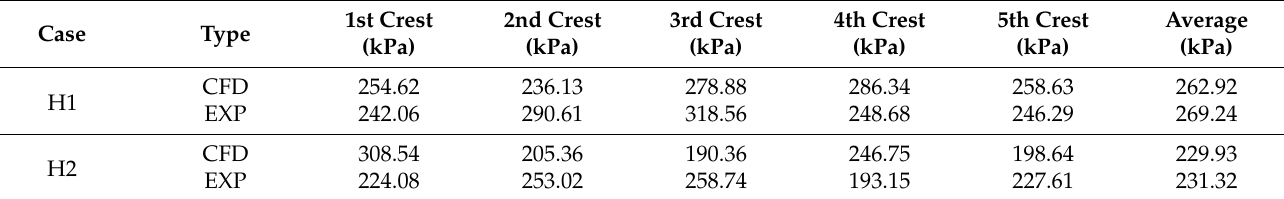
Figure 13. Comparison of slamming pressure at K1 between experimental data and numerical results. Test conditions are: ( a ) H = 15 m, T = 9 s; ( b ) H = 15 m, T = 10 s. Table 6. The results are observed over five wave periods.